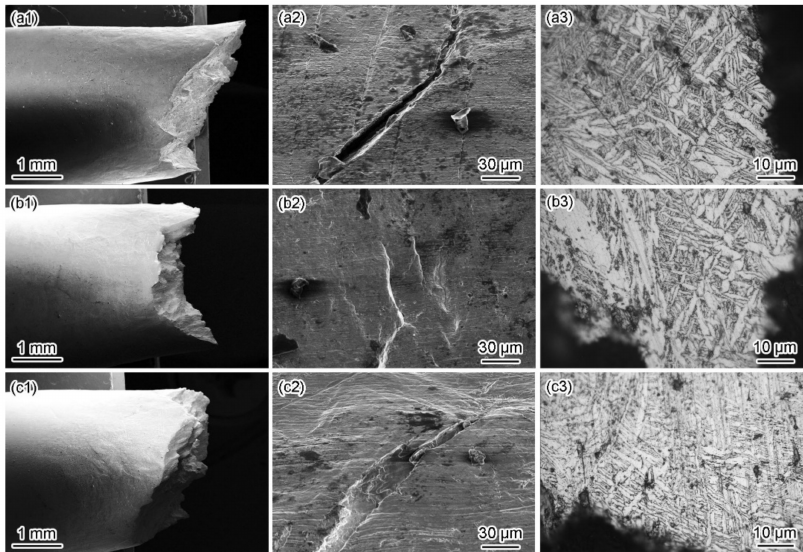
Figure 10. Fracture side morphologies in simulated a shallow − sea environment at − 1.5 V ( a ), E corr ( b ), and 1.5 V ( c ). Macromorphology of fracture side at − 1.5 V ( a1 ), E corr ( b1 ), and 1.5 V ( c1 ); micromorphology of secondary crack at − 1.5 V ( a2 ), E corr ( b2 ), and 1.5 V ( c2 ); metallography of main crack at − 1.5 V ( a3 ), E corr ( b3 ), and 1.5 V ( c3